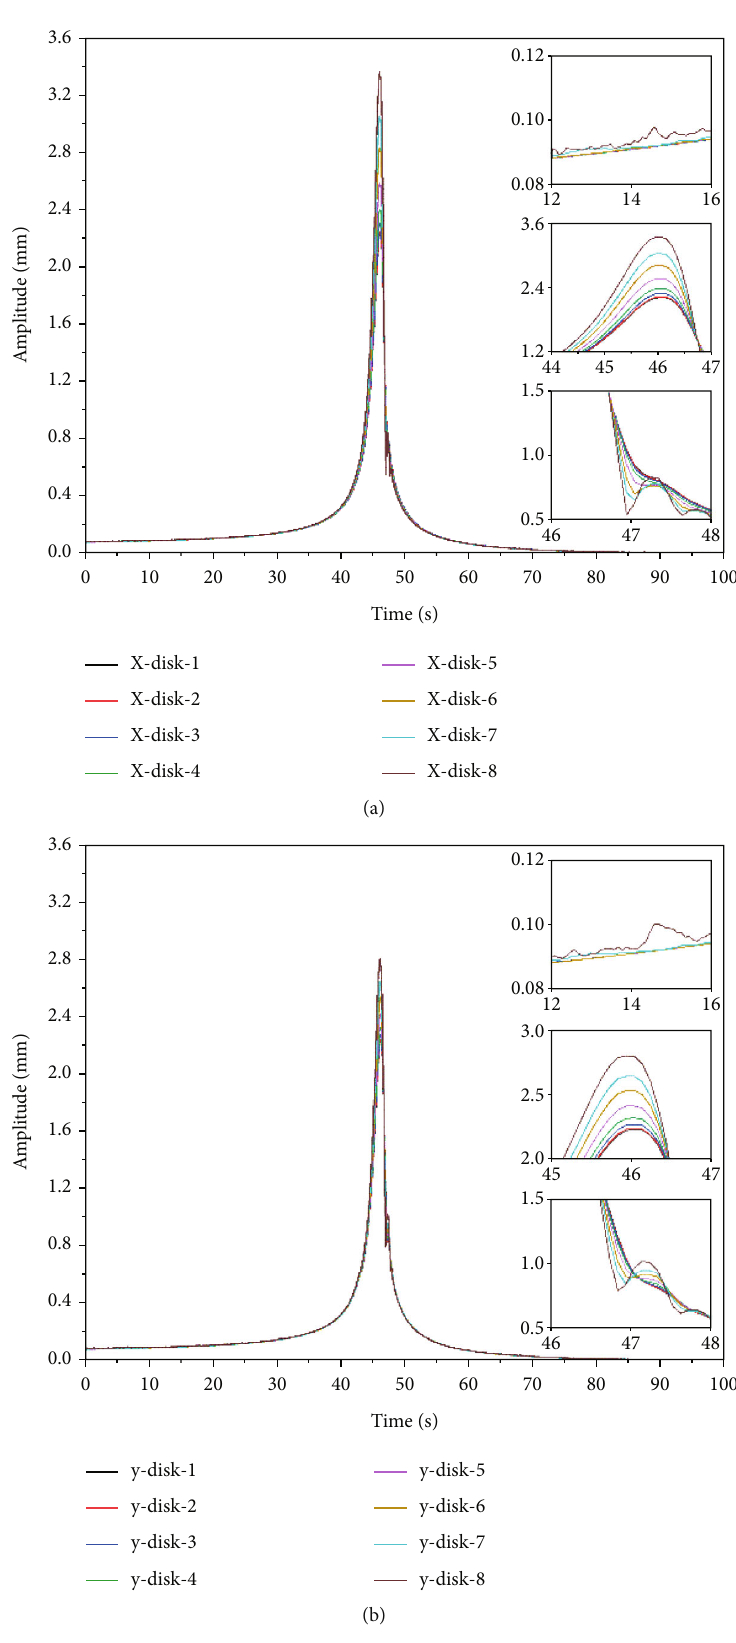
Figure 21: Variations of the node displacements at the rear bearing during run-down process. (a) Response in the x -axis direction. (b) Response in the y -axis